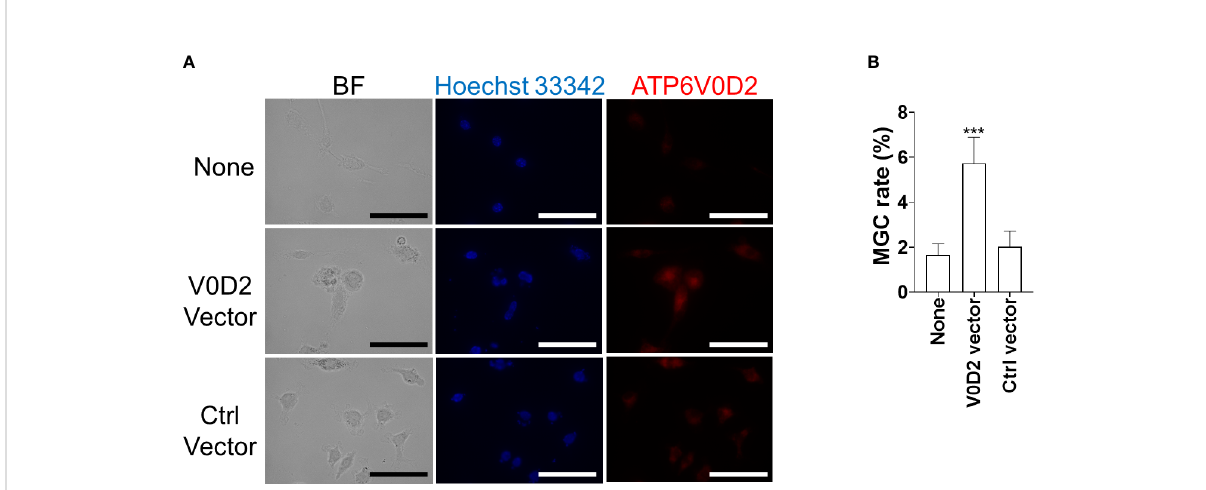
FIGURE 5 Overexpression of ATP6V0D2 promotes MGC formation in BMDMs. (A) BMDMs were transfected with either a vector coding ATP6V0D2 or a control vector and were stained with anti-ATP6V0D2 antibody and Hoechst 33342. BF, bright fi eld. (B) Cells with two or more nuclei were counted as MGCs. Over 100 cells for each experiment were counted for calculating MGC rates. Means ± SD of three independent experiments are shown. *** P < 0.001 by one-way ANOVA followed by Dunnett ’ s multiple comparisons test.